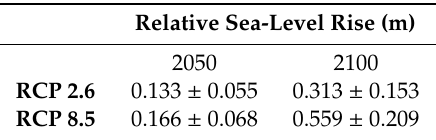
Table 2. Sea-level projections in the Assessment Reports 5 Representative Concentration Pathways (RCP) 2.6 and RCP 8.5 scenarios estimated for the Taranto coastal zone.